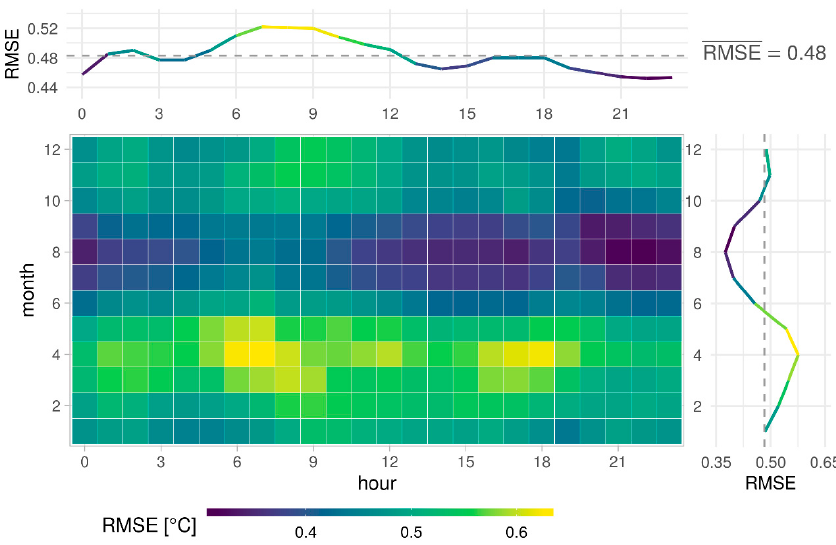
Figure 15. The 5-fold cross-validated root mean square error (RMSE) of the Stage 3 GAM model across 2004–2017, averaged by hour (upper panel) and month (right panel).